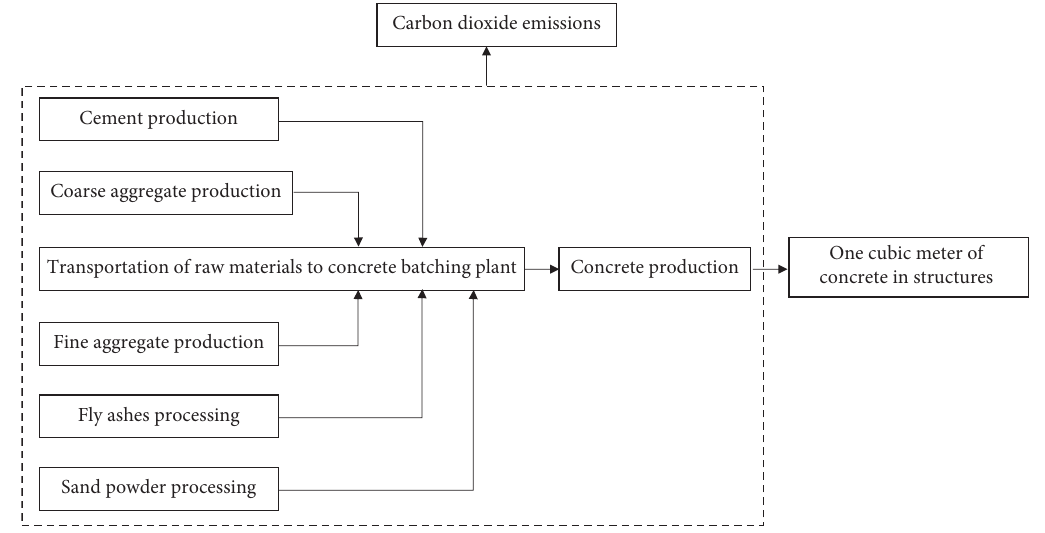
Figure 3: Processes involving CO 2 emissions in the production of a cubic meter of